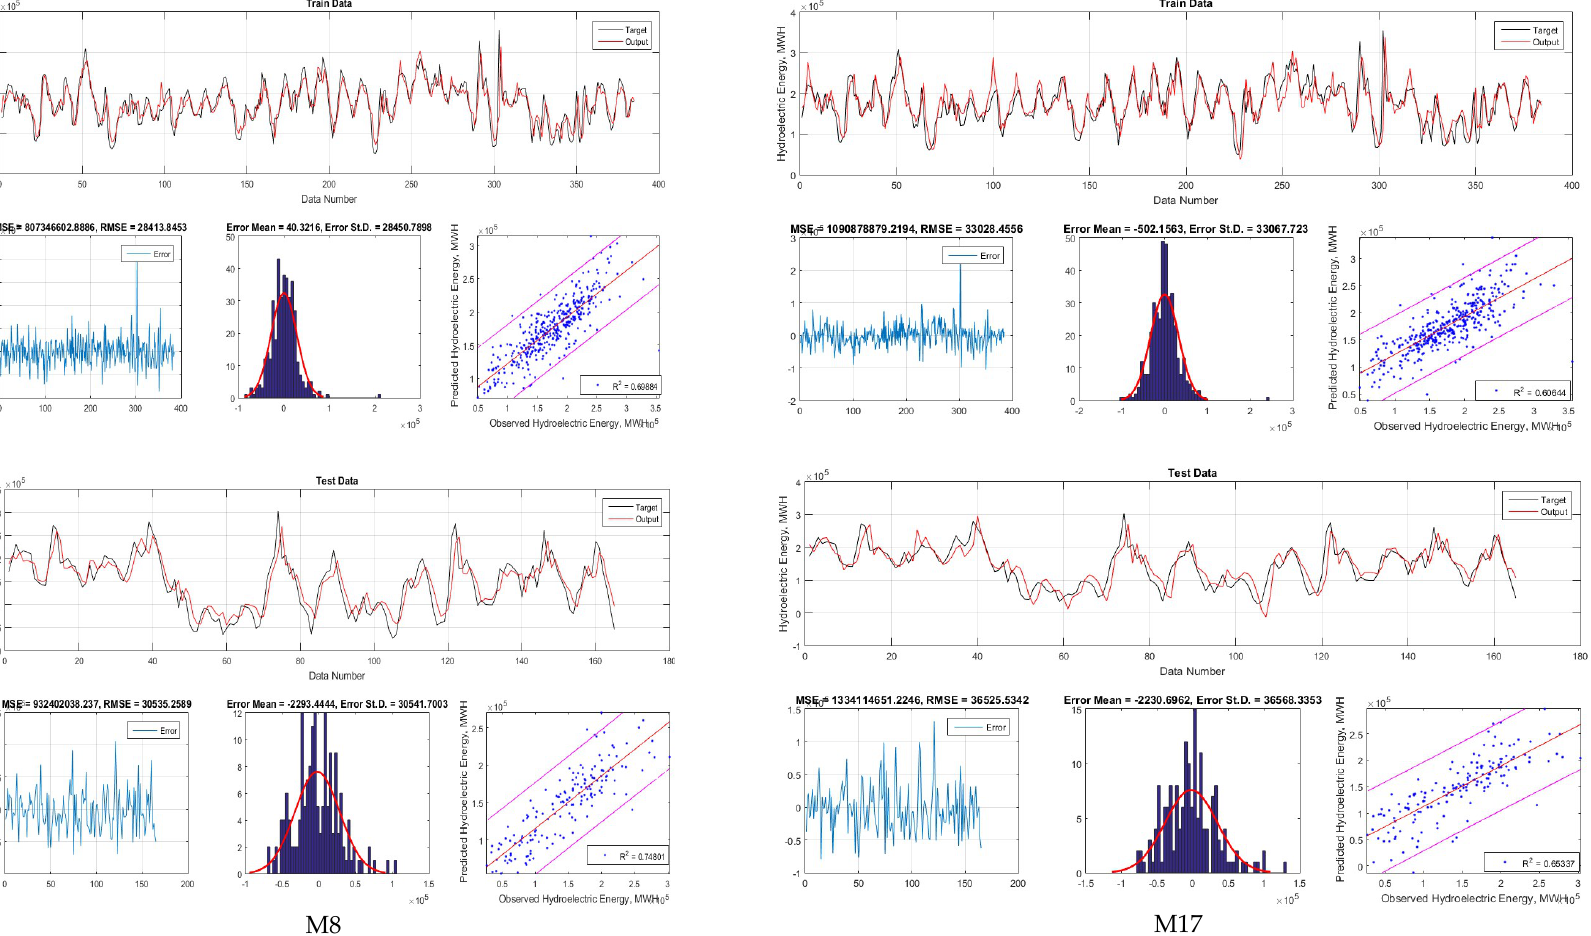
Figure 7. Observed and forecasted time series of hydropower generation using GWO-ANFIS.